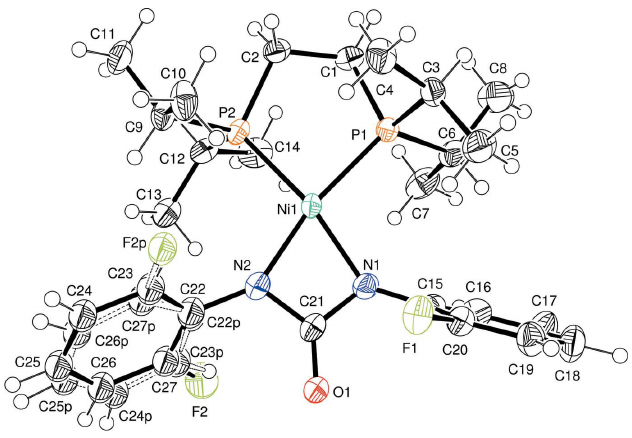
Figure 1 The molecular structure of [Ni(oFPU)(dippe)], showing the atom labelling. Displacement ellipsoids are drawn at the 50% probability level.